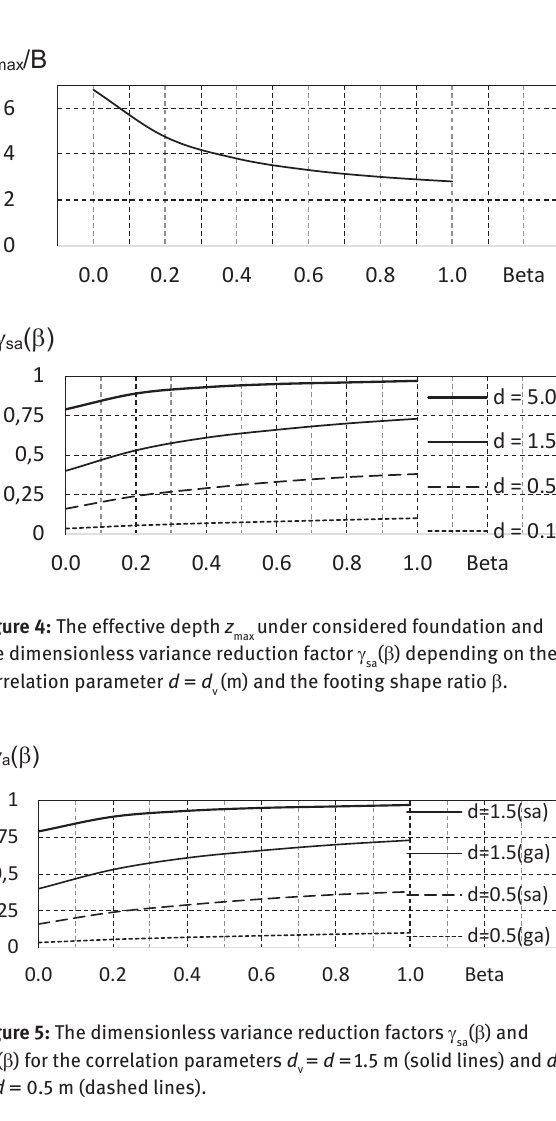
= d = 1.5 m (solid lines) and d v